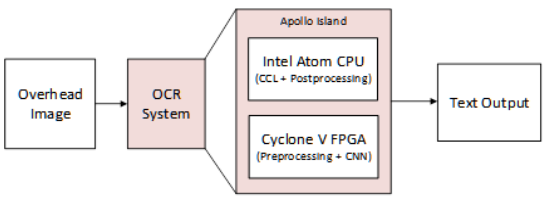
Figure 1. Industrial Setup for fast